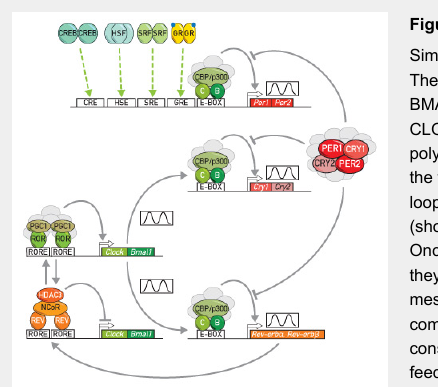
Simplified molecular model of the mammalian circadian oscillator. The two transcription factors CLOCK (C) (or its closely related paralog NPAS2) and BMAL1 (B) lie at the centre of the two coupled feedback loops in clock gene expression. CLOCK and BMAL1 recruit the coactivator proteins CBP/p300 and a few other polypeptides (shown in grey) and thereby activate the transcription of their target genes in the first feedback loop ( Per1 , Per2 , Cry1 , Cry2 ) and in the second (accessory) feedback loop ( Rev-erbα , Rev-erbβ ). Together with a large number of additional polypeptides (shown in grey) PER1, PER2, CRY1, and CRY2 assemble into large protein complexes. Once these repressor complexes have reached a threshold concentration and/or activity, they annul the transactivation activity of CLOCK and BMAL1. Under these conditions, the messenger PER and CRY mRNAs and proteins are no longer made, and the repressor complexes diminish until they no longer inhibit the activity of CLOCK and BMAL1. As a consequence, a new 24-hour PER and CRY production cycle can ensue. In a second feedback loop CLOCK and BMAL1 activate and PER/CRY complexes repress the transcription of the genes encoding the two repressors REV-ERBα and REV-ERVβ (REV). The circadian expression of REVs results in the rhythmic repression of the Clock and Bmal1 genes. When REV concentrations are low,